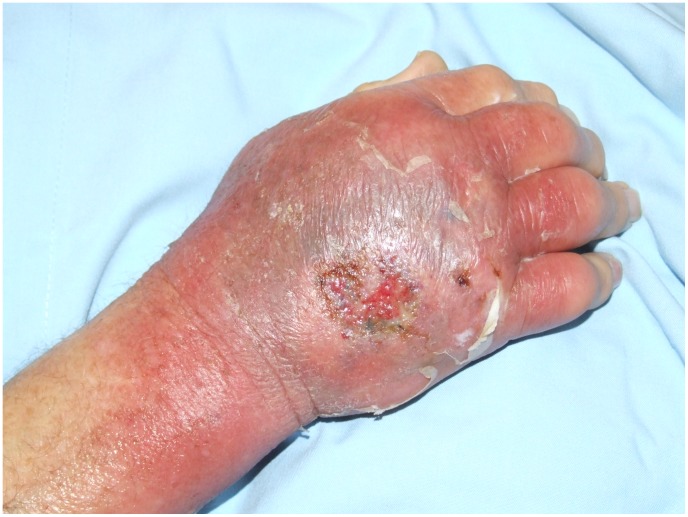
Oedematous M. ulcerans lesion dorsum of left hand.